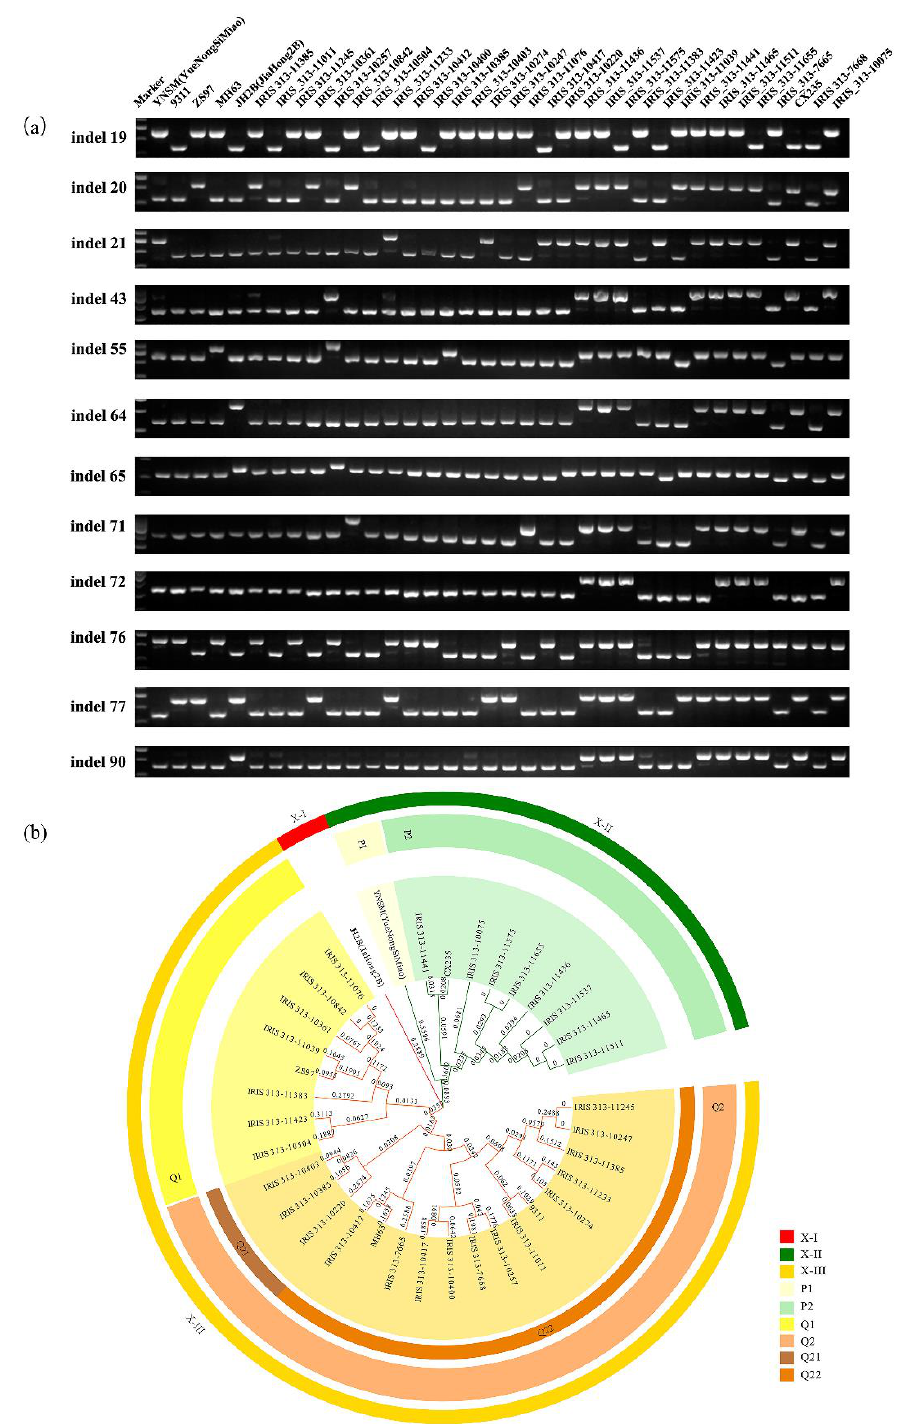
Figure 4. PCR amplification and phylogenetic tree of 36 indica rice varieties screened using InDel markers. ( a ) PCR profiles of 36 indica rice varieties with 25 InDel markers. M: DL2000, DNA marker. YueNongSiMiao (YNSM) was used as a control. ( b ) Phylogenetic tree of 36 indica rice varieties based on the 25 InDel markers using the UPGMA dendrogram. The different colours represent the name of groups and subgroups. The numbers in the phylogenetic tree represent evolutionary distances of the tree structure below this node.